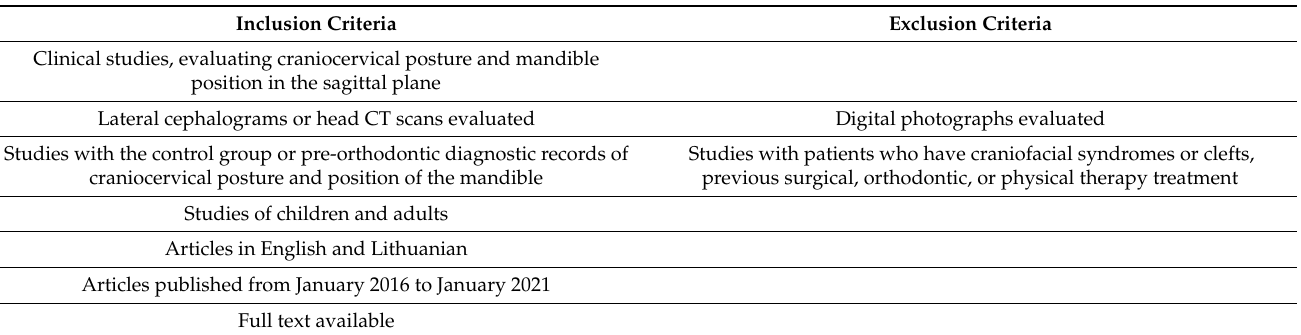
Table 2. Inclusion and exclusion